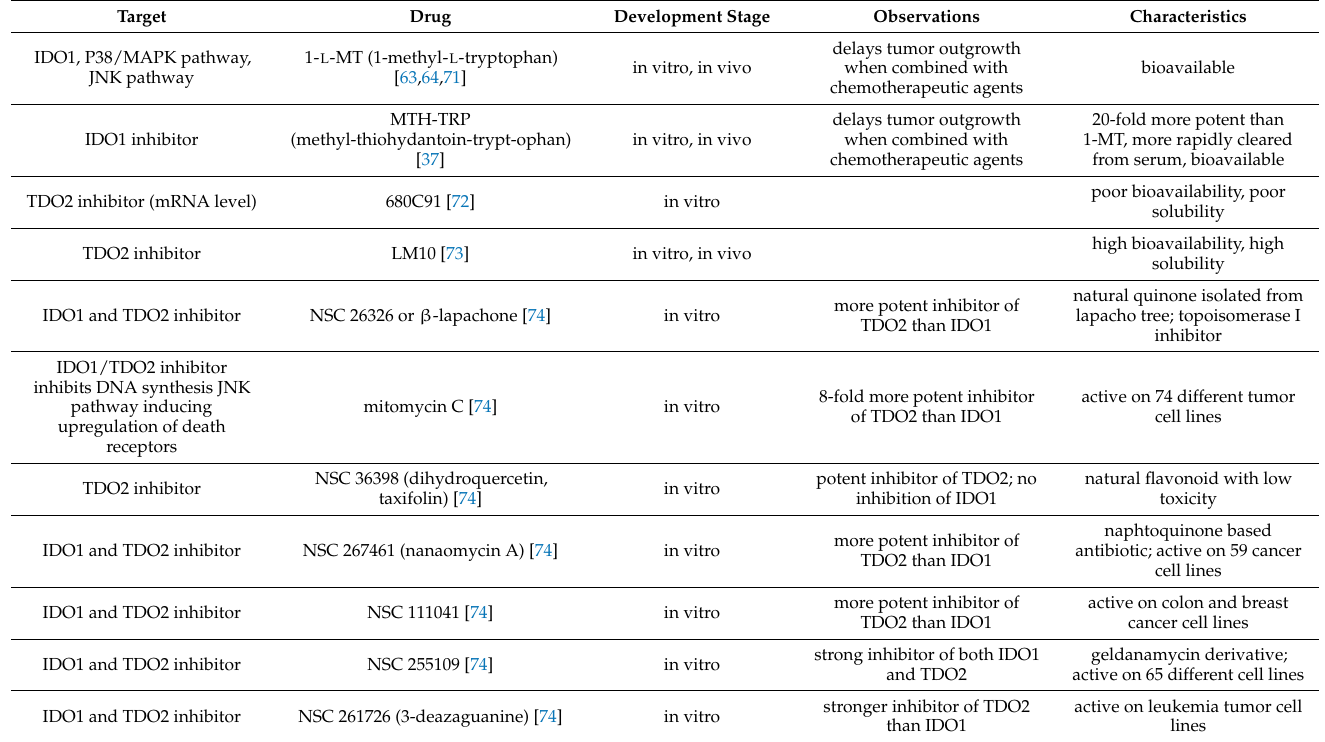
Table 2. List of molecules or drugs tested as inhibitors of IDO1 and/or TDO2 in vitro, some of which are from the library of the National Institute of